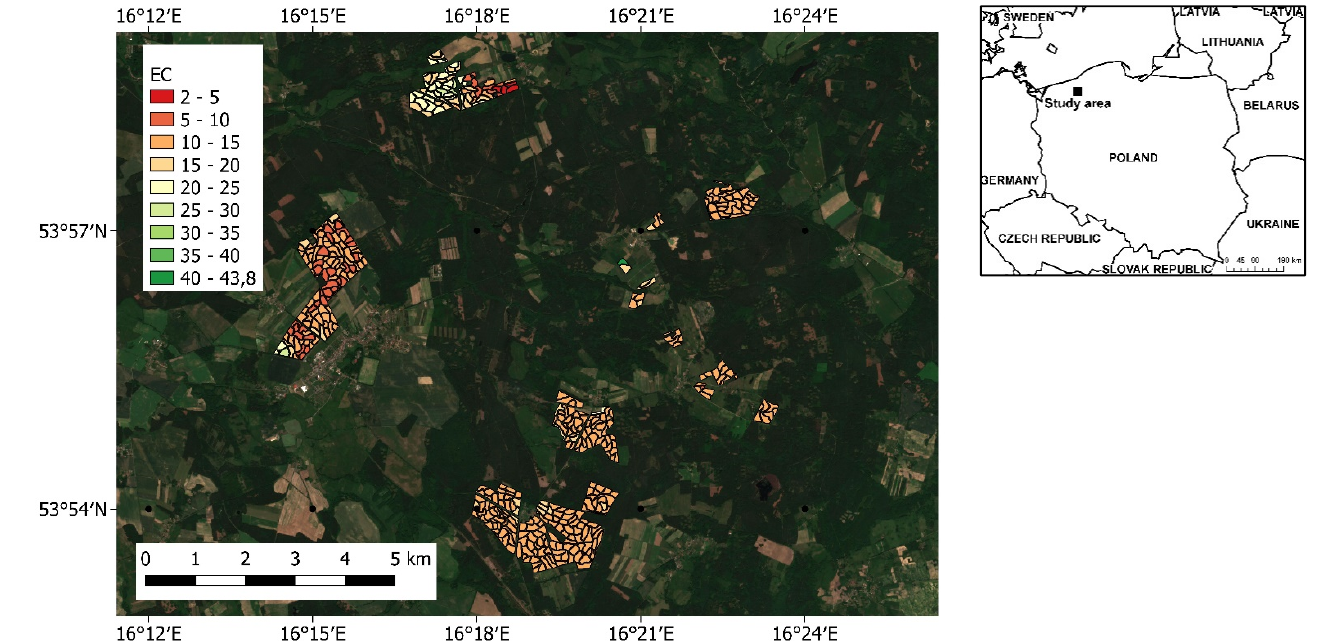
Figure 1. Location of the study area and management zones with average EC (in mS/m) within crop fields which were included in the study.